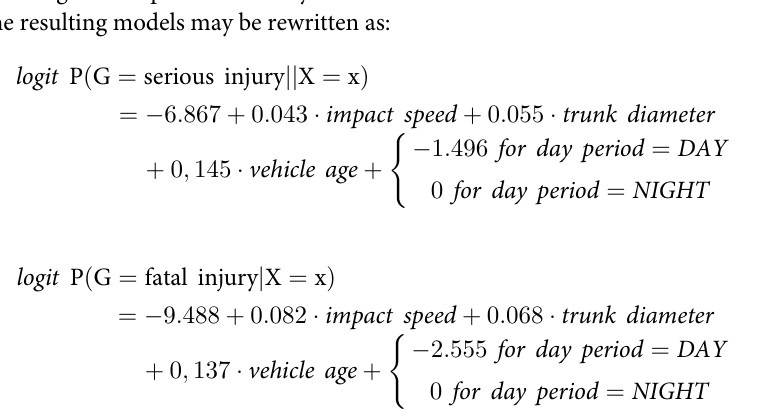
Standard errors are relatively small despite the correlation between impact speed and trunk diameter. If the variable impact speed increase about 10 kilometres per hour, the probability of serious injury increases 1.044 10 = 1.54 times compared to the slight injury. In case of fatal injury, the probability increases 1.086 10 = 2.28 times compared to the slight injury. Similarly, in case of tree diameter increase about 10 centimetres, the probability of serious increases 1.057 10 = 1.74 times and probability of fatal injury 1.070 10 = 1.97 times, compared to the refer- ence category slight injury. The vehicle age coefficient difference between serious and fatal injury are very similar. It could be assumed the increase of severe injury probability (fatal and serious) 1,15 10 = 4,1times with increase in vehicle age about 10 years. The interpretation of the variable day period was reduced only to the signs of regression coefficient because of higher standard errors values of the categories of this variable. If the crash occurs at night, the probability of more severe injury has been higher compared to the day.